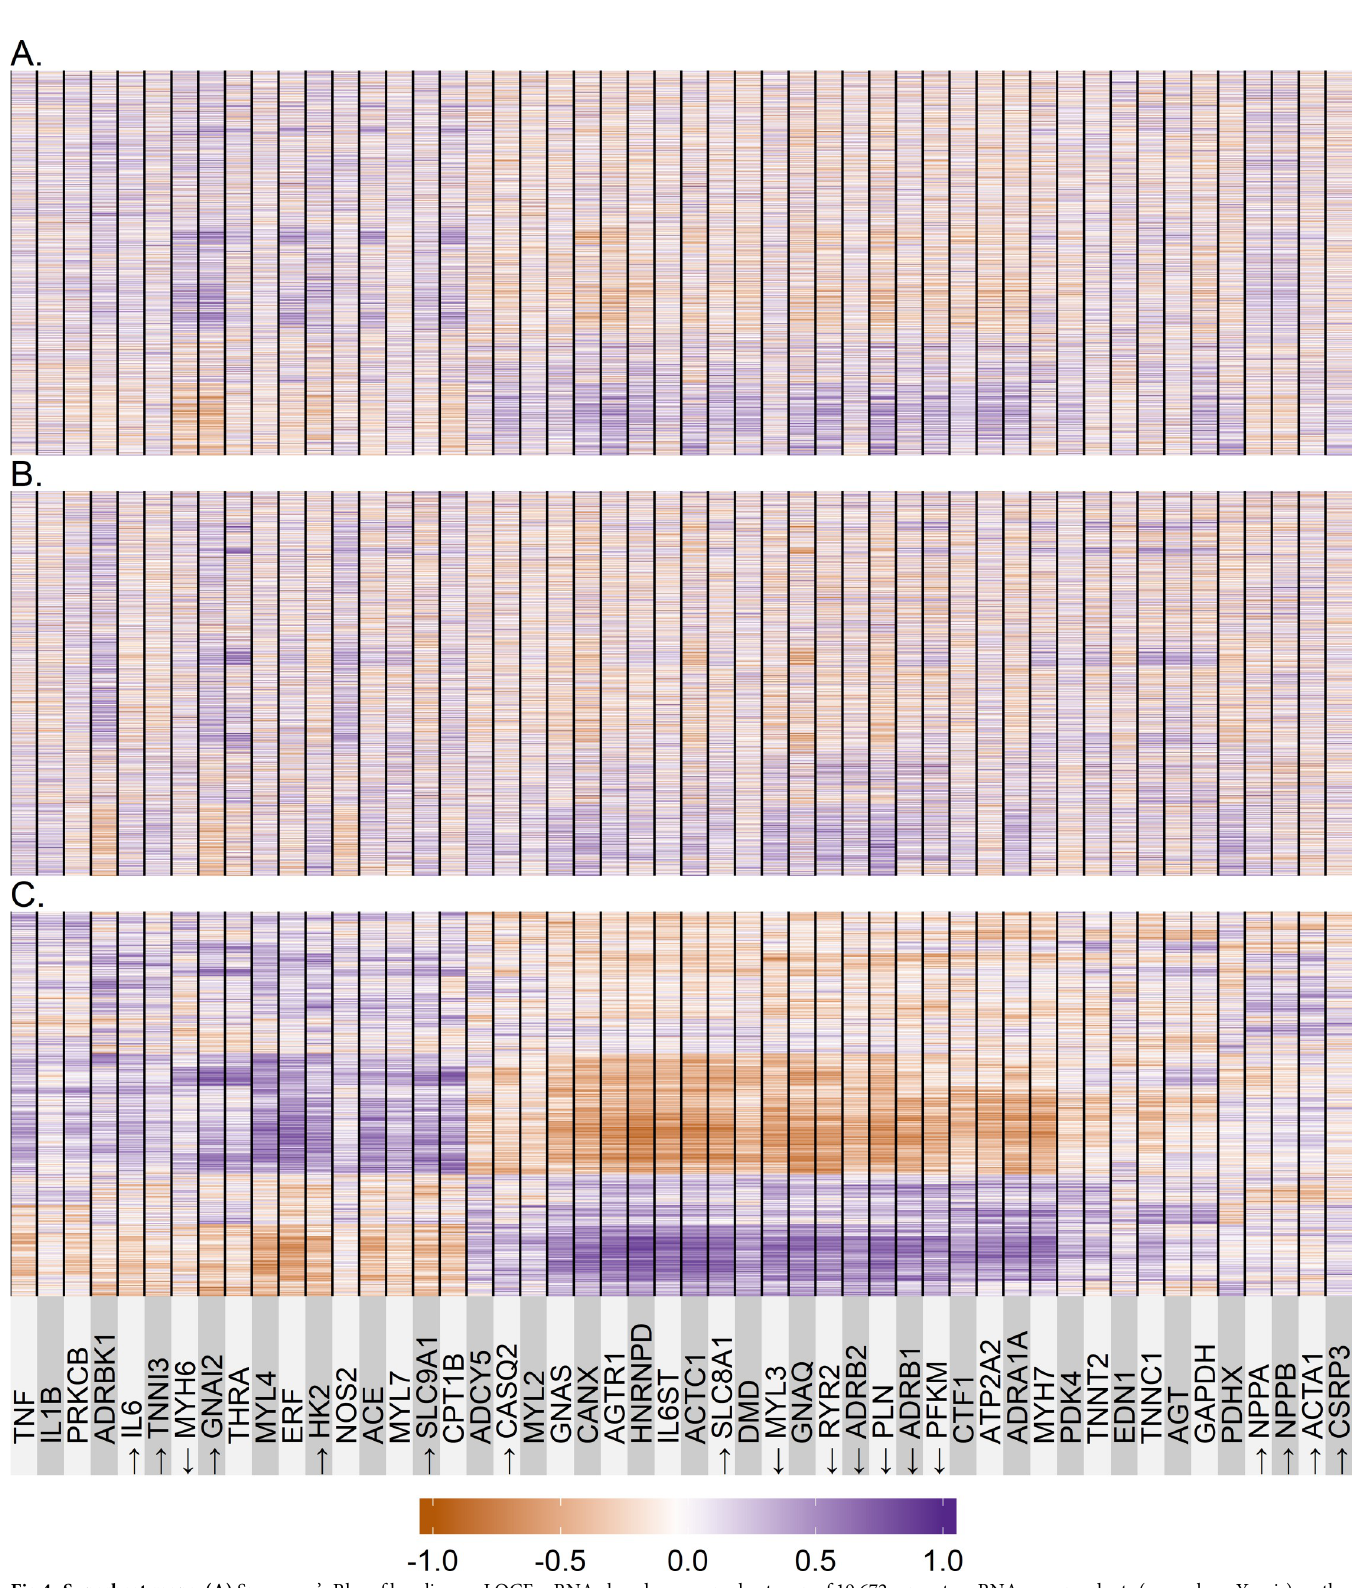
Fig 4. Superheat maps. (A) Spearman’s Rho of baseline vs. LOCF mRNA abundance, superheat map of 19,672 separate mRNA gene products (rows along Y-axis) vs. the 50 candidate gene mRNAs, patients in tile 1 of LVEF change (Fig 2). Arrows indicate candidate genes with concordant changes measured by RT-qPCR and microarray